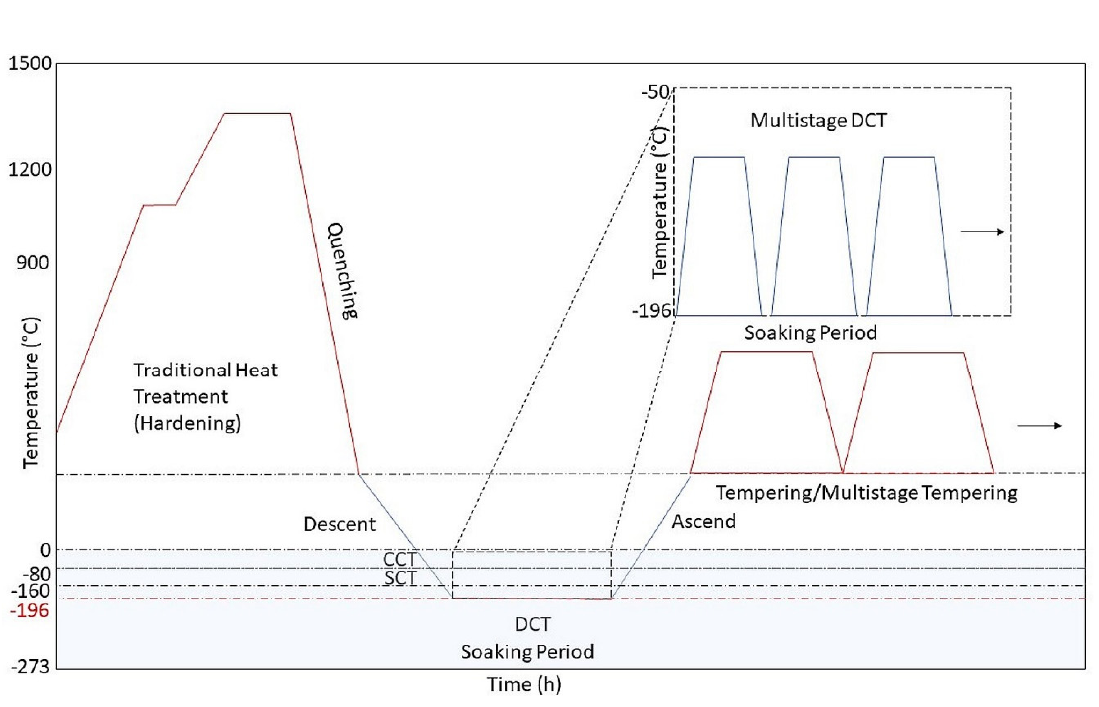
Figure 1. This figure represents the scheme of the most conventional cryogenic treatment process, with included preparation and post-preparation (warming and cooling) of the metallic material. With added different possibilities of the method. Dashed lines mark the limit temperatures of various cryogenical treatments (conventional cold treatment (CCT), shallow cryogenic treatment (SCT) and deep cryogenic treatment (DCT)).